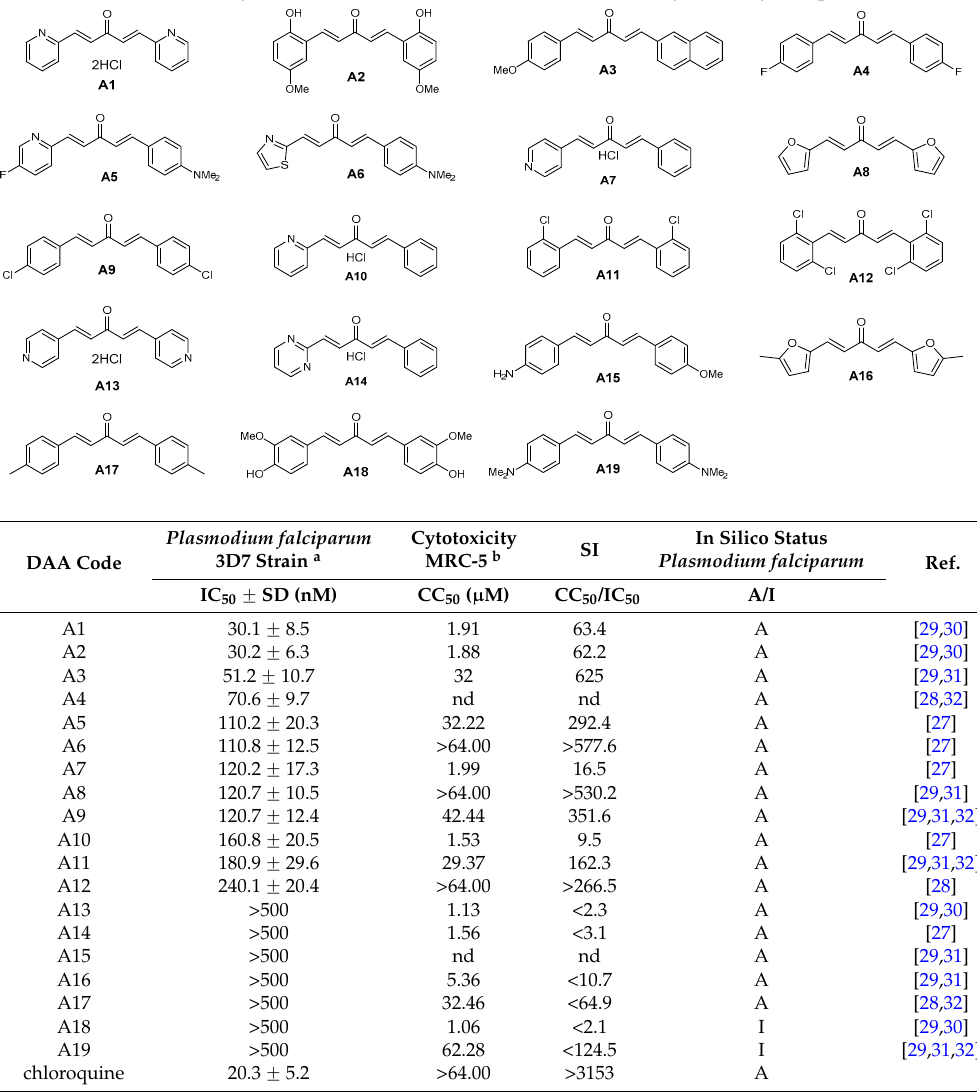
Table 1. Structures of diarylideneacetones (DAAs), antimalarial effects, cytotoxicity and predicted